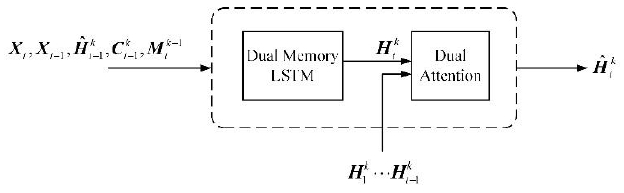
Figure 4. DMA unit.